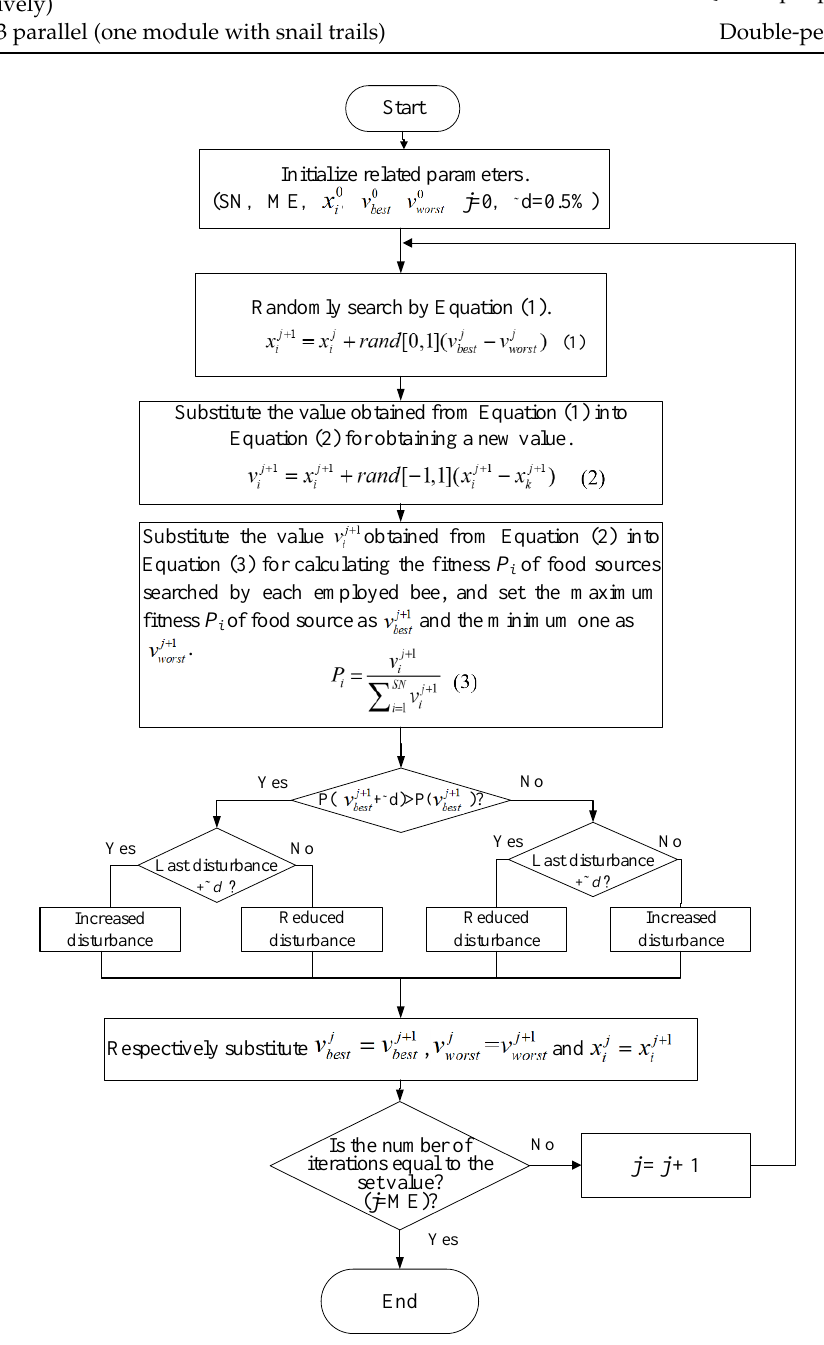
Figure 5. Flowchart of the I-ABC algorithm .